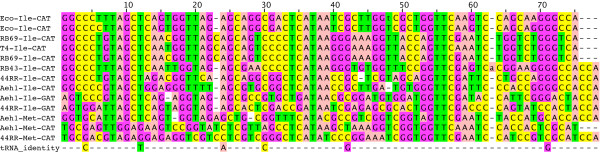
tRNA alignment. Putative lysidine-modified phage tRNA-Ile sequences were aligned by secondary structure using clustalW. E. coli modified tRNA-Ile and phage Met-CAU and Ile-GAU sequences are shown for comparison.